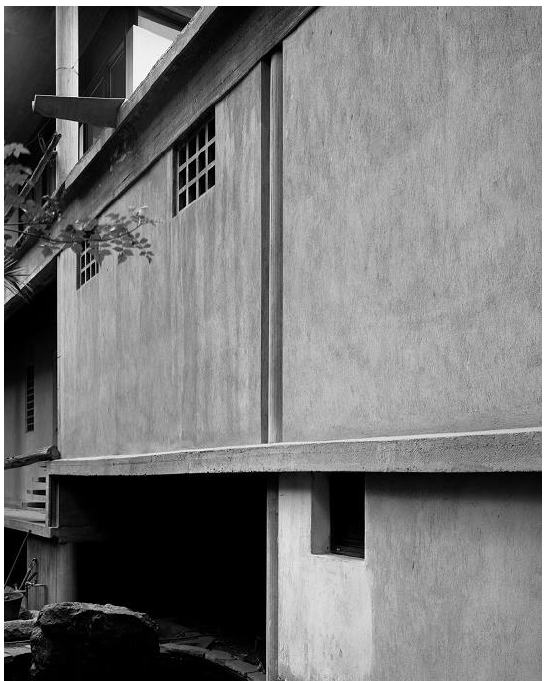
Figure 14. Neoptolemos and Maria residence, details.